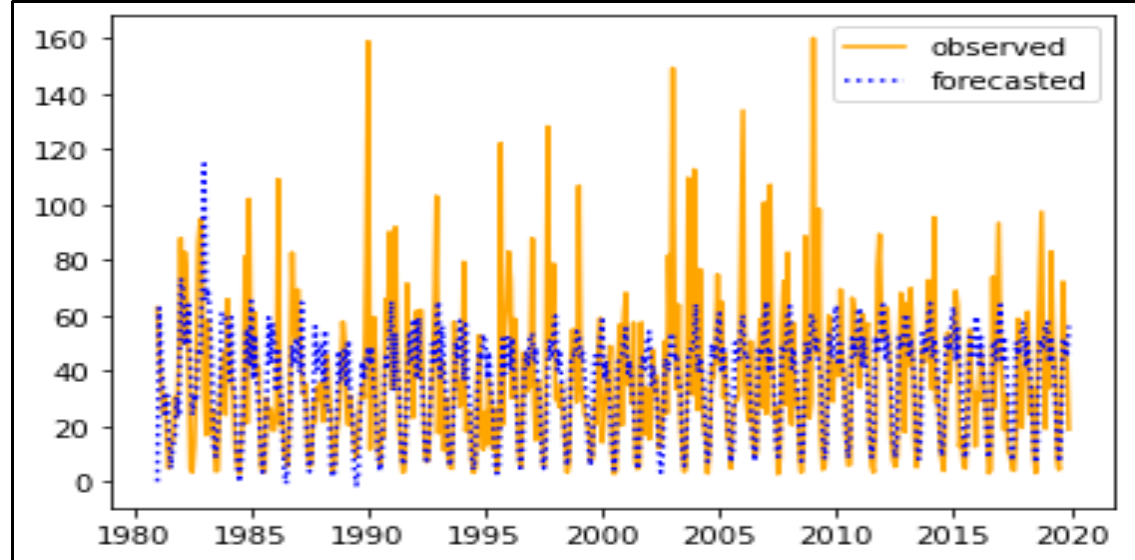
Figure 4. Comparison between forecasted and observed data.